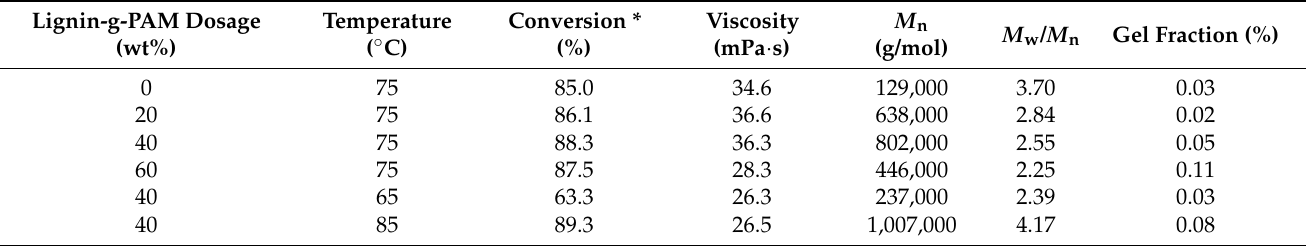
Table 1. Reversible addition–fragmentation transfer (RAFT) polymerization conditions and main characteristics of pure MMA- co -BA and lignin-based hybrid acrylate